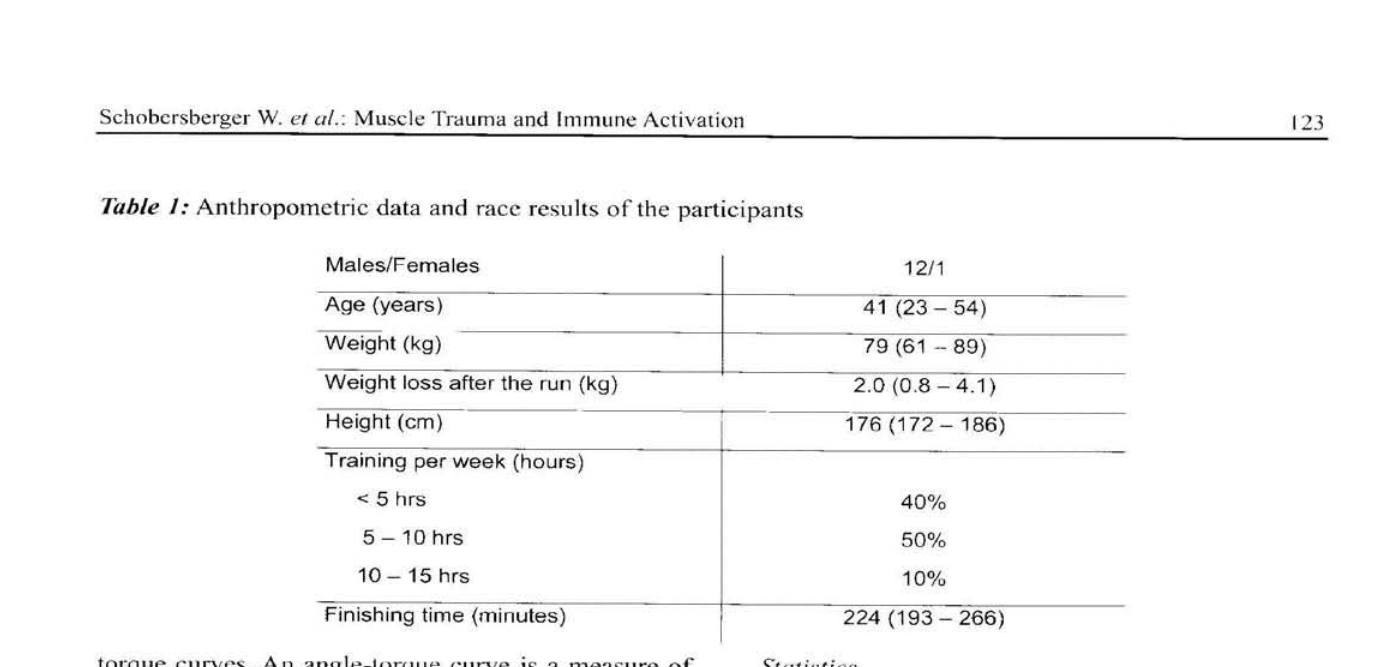
Table 1: Anthropometric data and race results of the participants